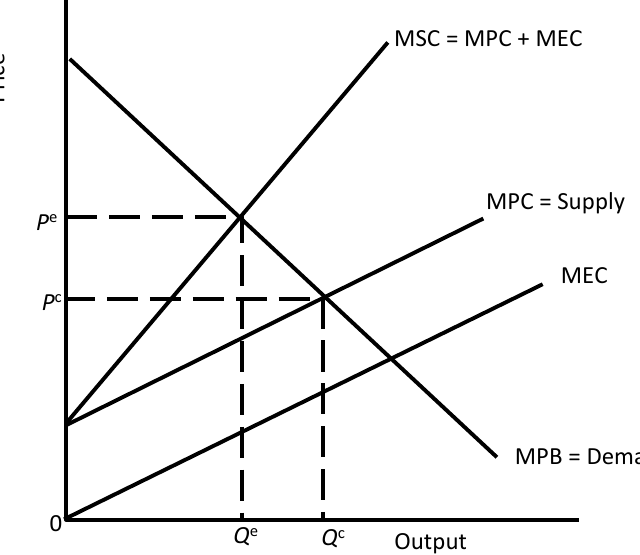
Figure 1. A model of negative